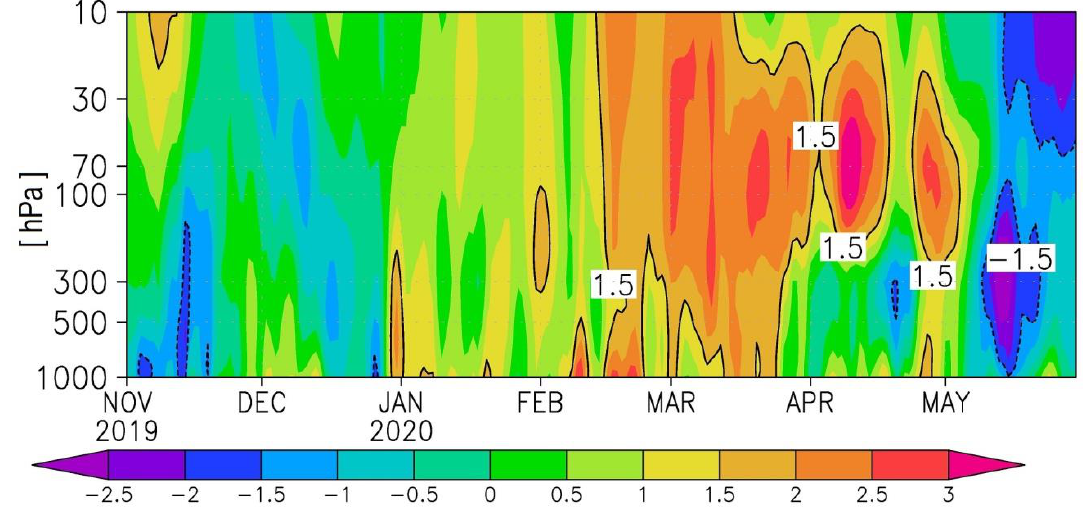
Figure 4. NAM index in November 2019–May 2020. Black solid and dashed contours correspond to +/− 1.5 σ, respectively.